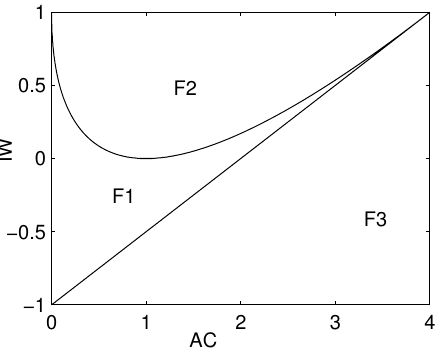
Figure 1: The previous convergence region of the simplified PSO algorithm, where IW and AC denote inertia weight ω and φ ,